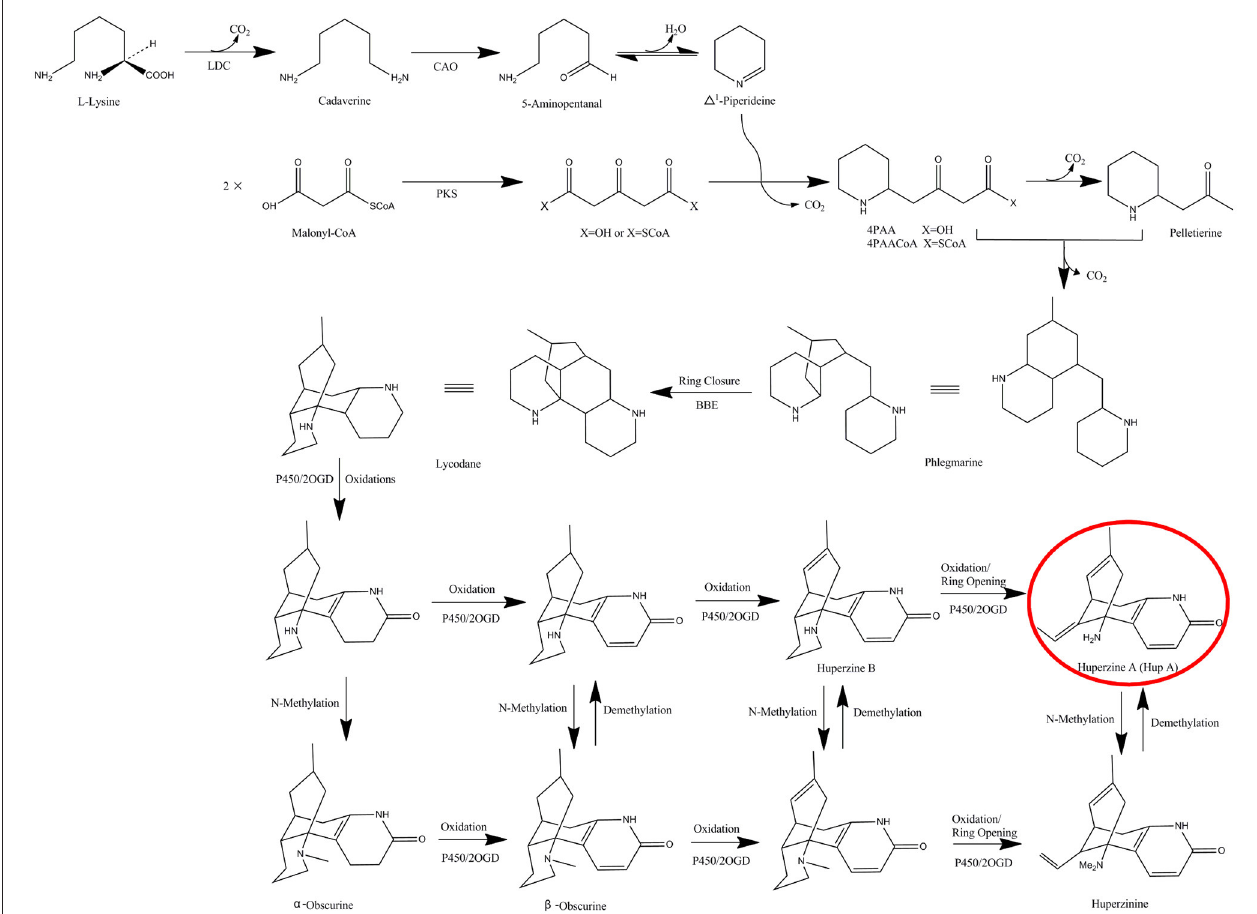
FIGURE 1 | The proposed biosynthetic pathway of HupA in H. serrata . LDC, lysine decarboxylase; CAO, copper amine oxidase; PKS, polyketides synthases; BBE, berberine bridge enzyme; 2OGD, 2-oxoglutarate-dependent dioxygenases.